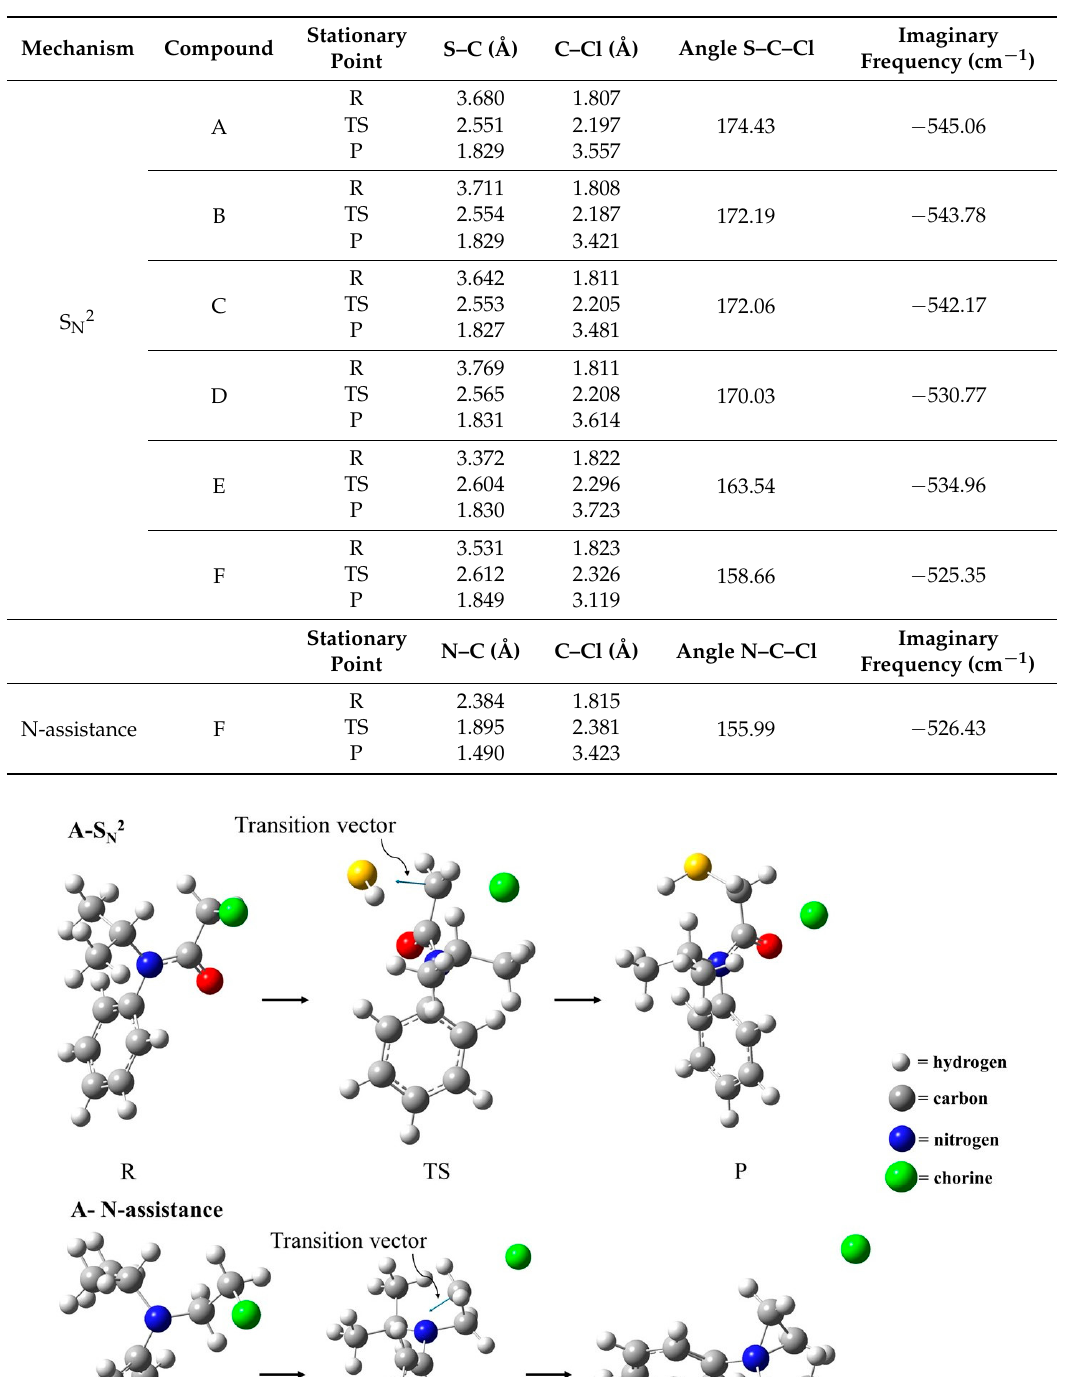
Table 3. Geometric parameters for reactants (R), transition state (TS), and products (P) at the